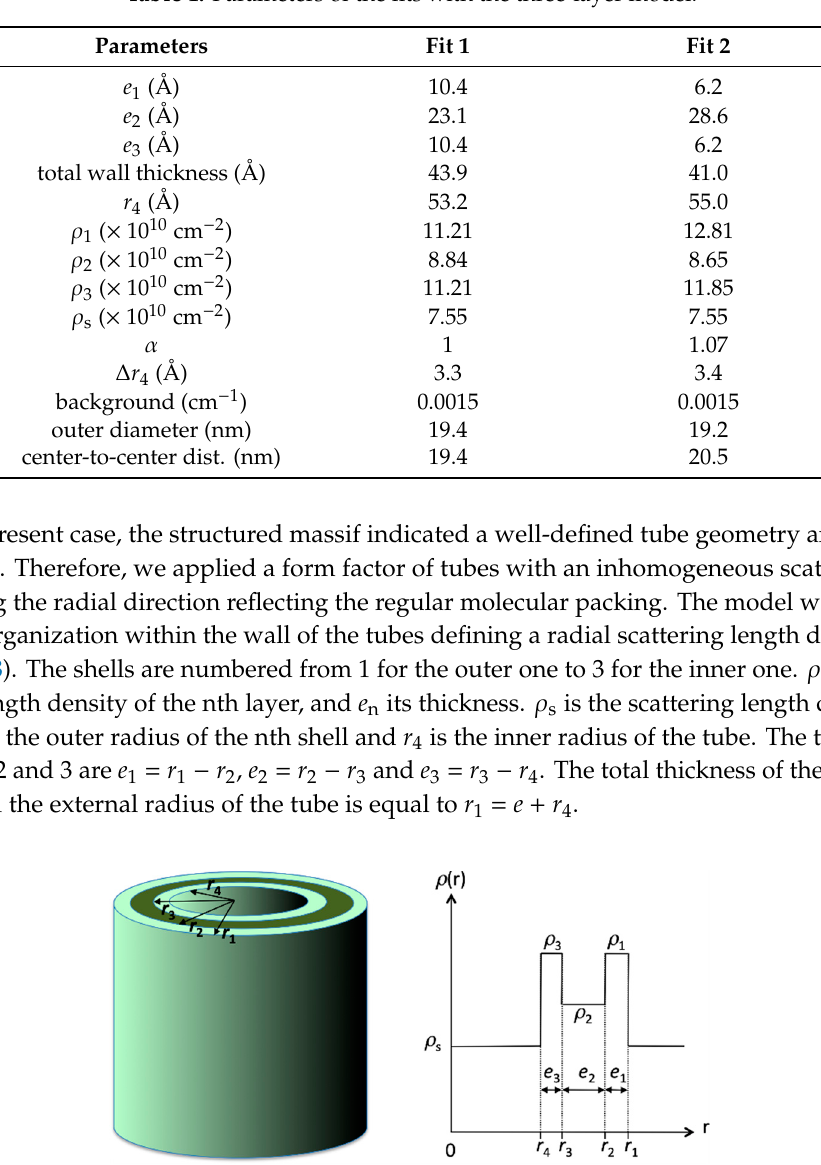
Table 1. Parameters of the fits with the three-layer model.